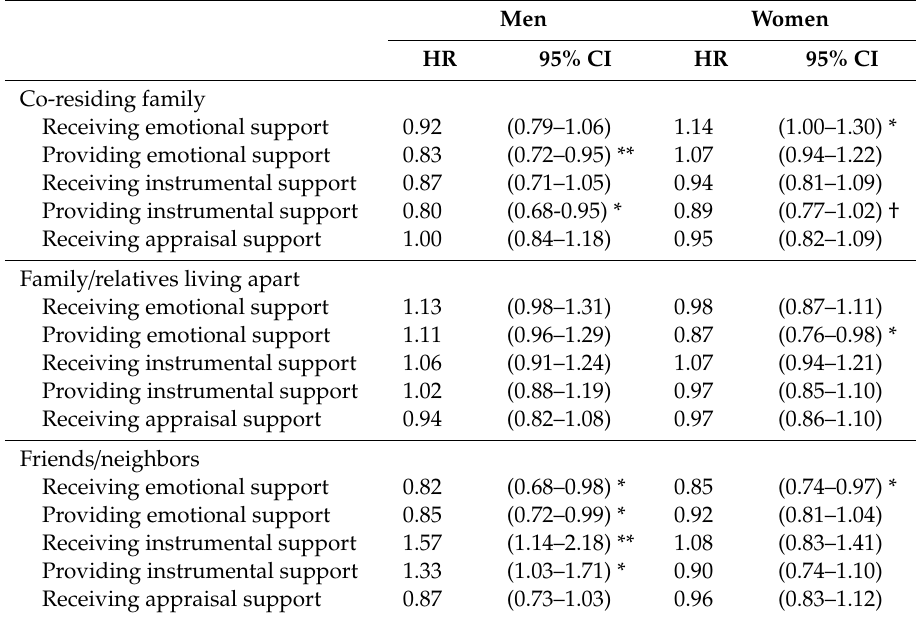
Table 4. Social support by source and type and incident